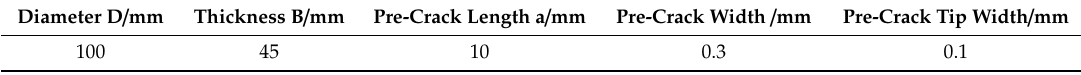
Table 1. Geometric parameters of notched semi-circular bend (NSCB)